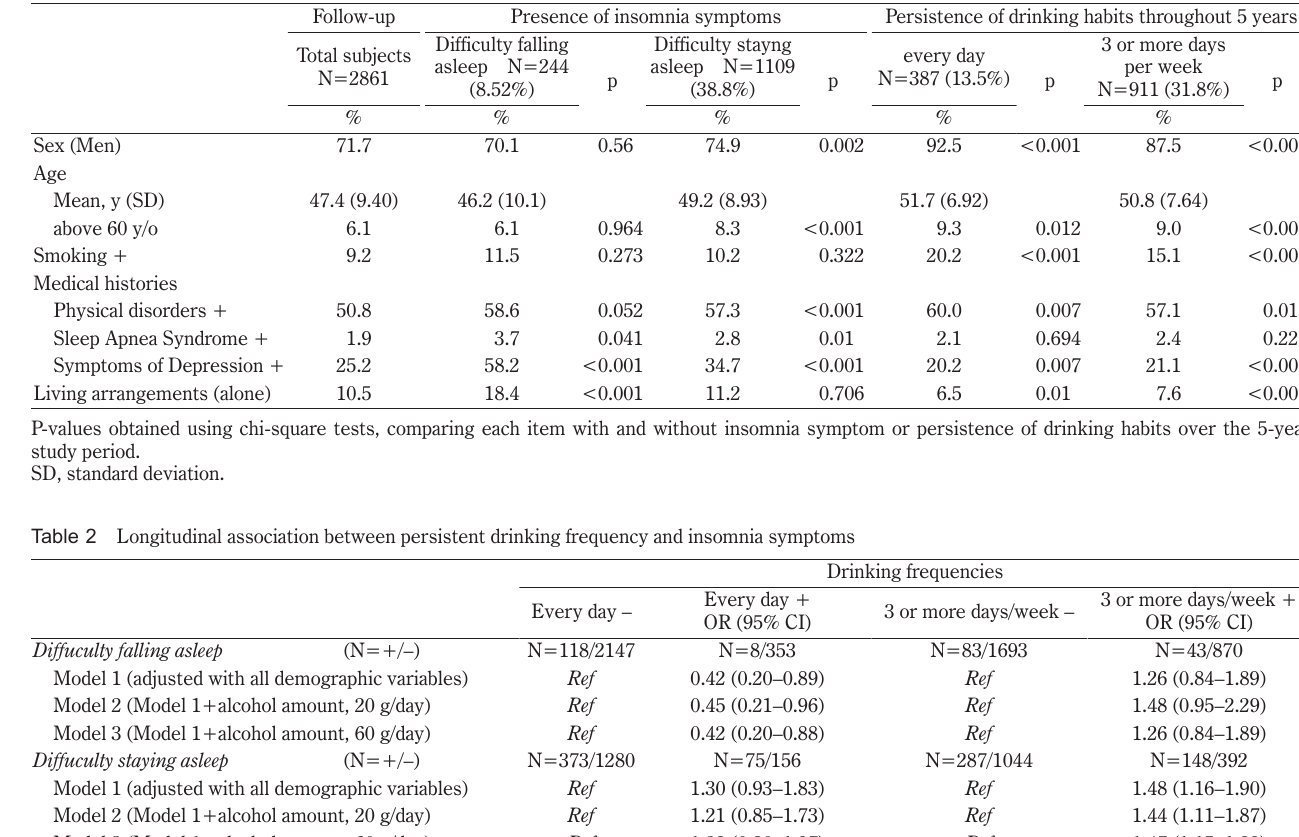
Table 1 Characteristics of participants at follow-up (2018) Follow-up Presence of insomnia symptoms